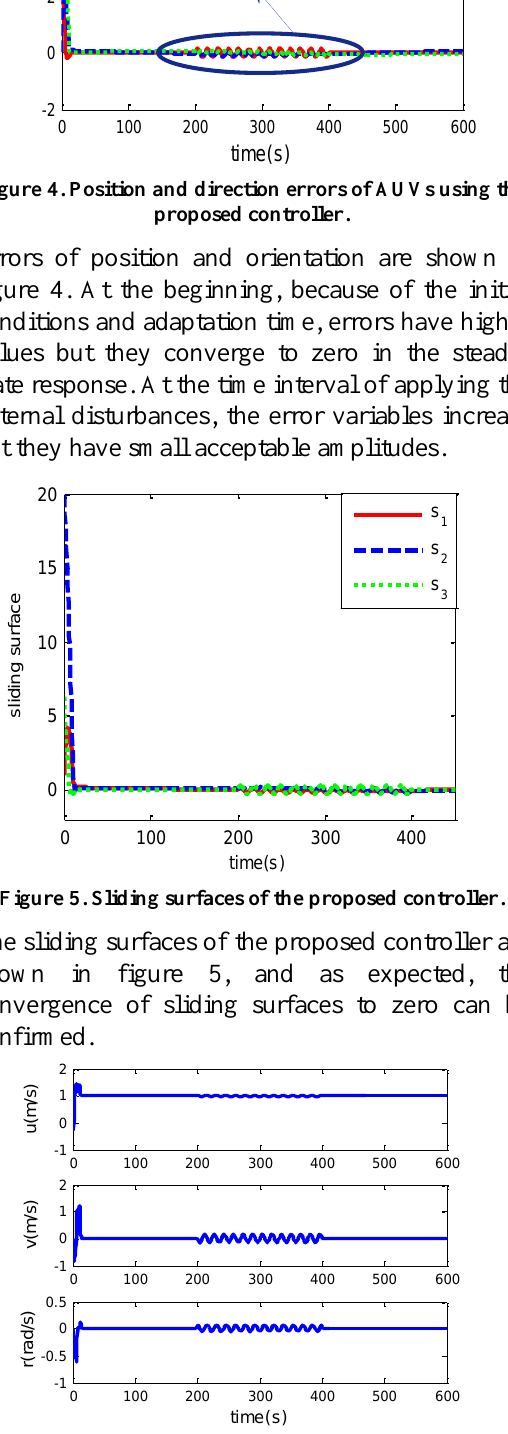
Figure 6. Linear and angular velocities of AUVs using the proposed controller.